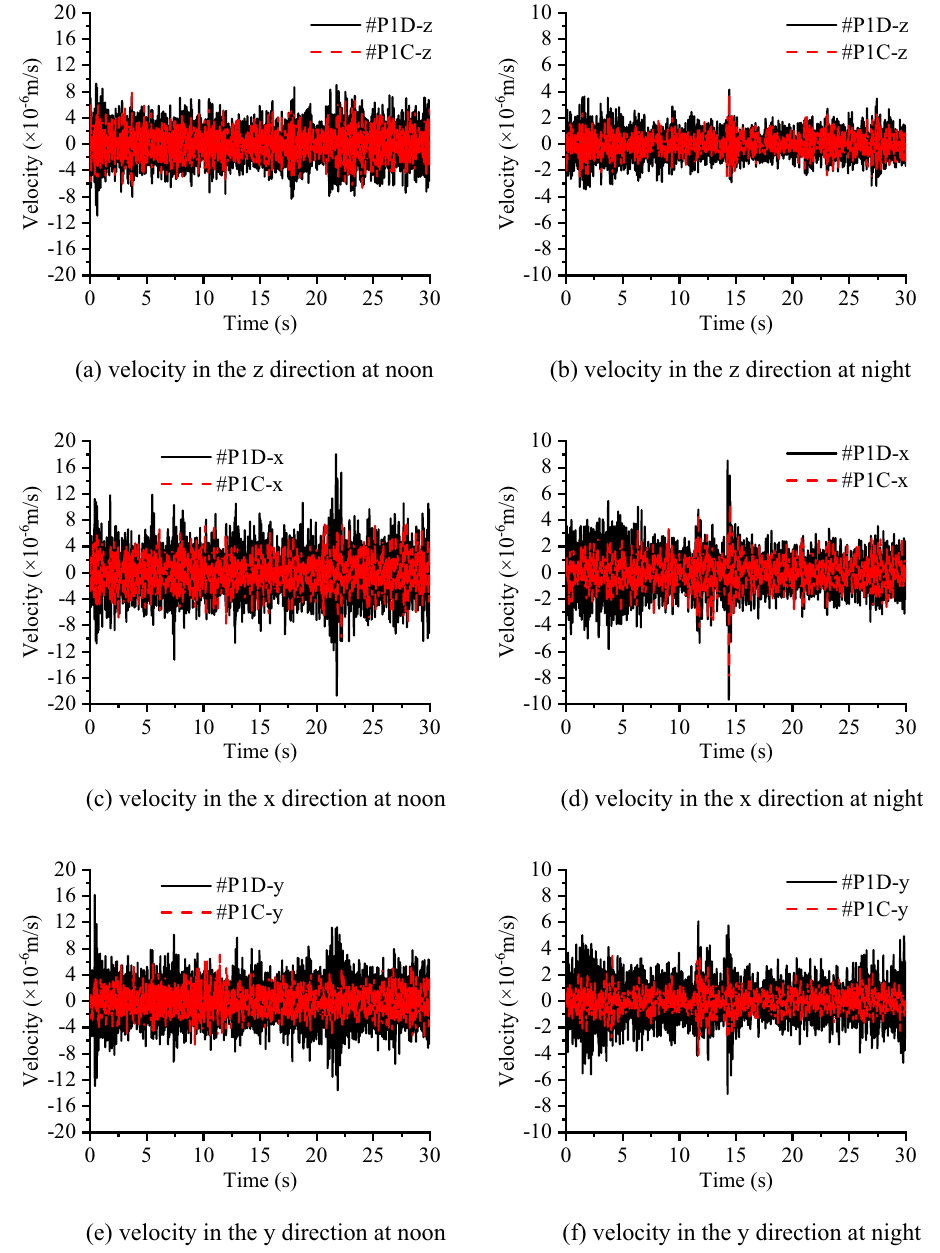
Figure 11. Comparison of measured velocities on the concrete layer and subsoil in group